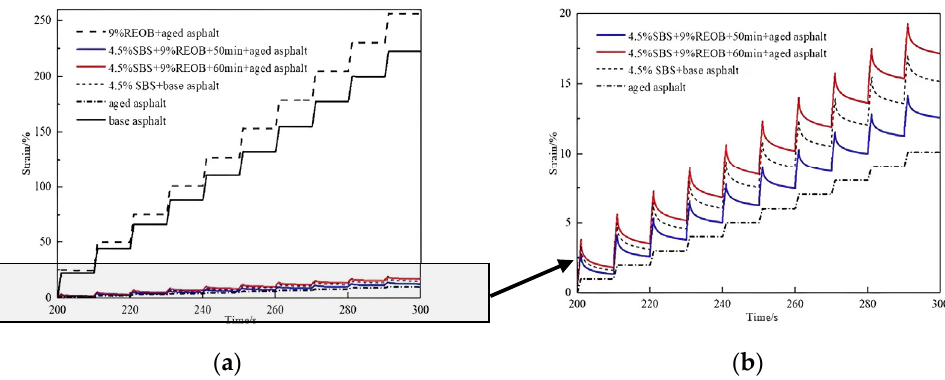
Figure 2. MSCR test results at 3.2 kPa stress level: ( a ) Test results of each asphalt; ( b ) Test results of